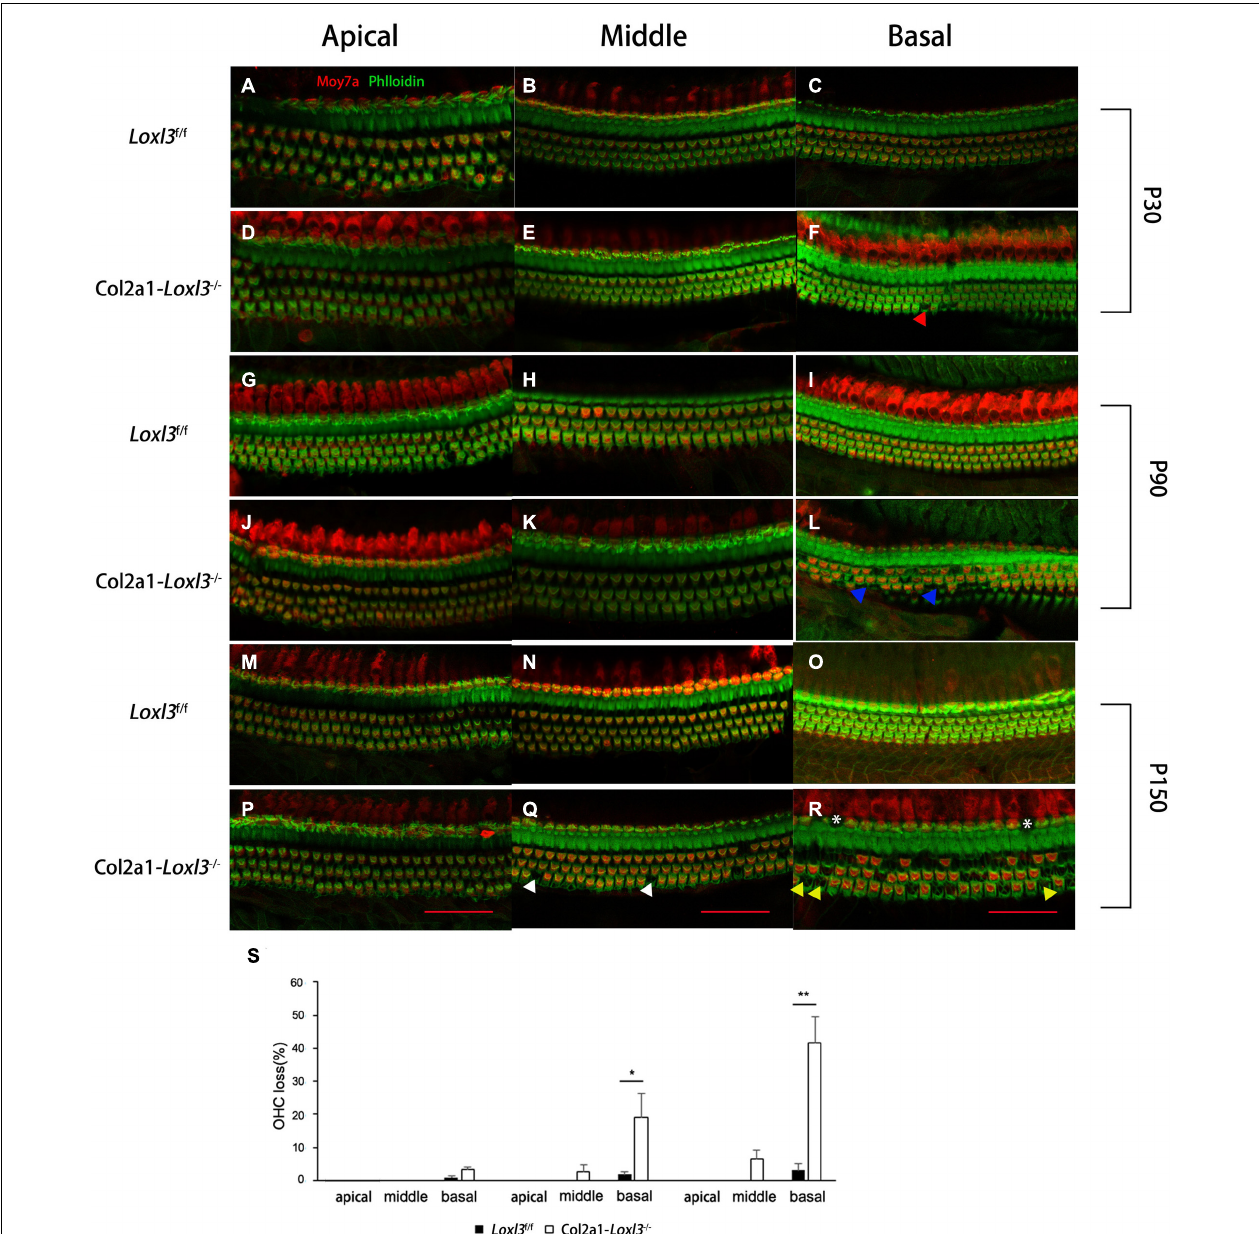
FIGURE 3 | Progressive degeneration of OHCs and IHCs in Col2a1–Loxl3 − / − mice. (A–F) Confocal images of cochlea hair cells in Loxl3 f / f and Col2a1–Loxl3 − / − mice at P30. Spotty loss of OHCs was observed in the cochlea basal turn (red triangle). (G–L) Confocal images of cochlea hair cells in Loxl3 f / f and Col2a1–Loxl3 − / − mice at P90. Approximately 19% OHCs loss was observed in the cochlea basal turn. (blue triangle). (M–R) Confocal images of cochlea hair cells in Loxl3 f / f and Col2a1–Loxl3 − / − mice at P150. Significant OHCs degeneration was observed in the cochlea basal turn (yellow triangle), with spotty loss of OHCs in the cochlea middle turn (white triangle). And a little loss of IHCs was also observed in the cochlea basal turn (white asterisk) Scale bars: 100 µ m. OHCs, outer hair cells;